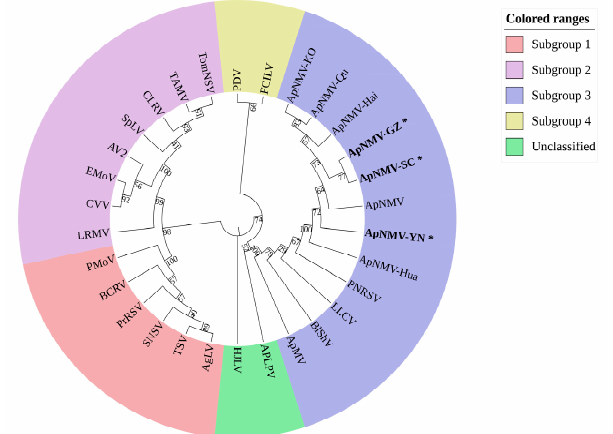
Figure 3. Phylogenetic tree based on the coat protein (CP) amino acid residues of ApNMV isolates with members of the genus ilarvirus. Subgroup 1: Ageratum latent virus (AgLV, NC022129), tobacco streak virus (TSV, NC003845), strawberry necrotic shock virus (SNSV, NC008706), blackberry chlorotic ringspot virus (BCRV, NC011555), privet ringspot virus (PrRSV, NC027930), parietaria mottle virus (PMoV, NC005854). Subgroup 2: asparagus virus 2 (AV2, NC011807), citrus leaf rugose virus (CLRV, NC003546), citrus variegation virus (CVV, NC009536), elm mottle virus (EMoV, NC003570), spinach latent virus (SpLV, NC003810), tomato necrotic streak virus (TomNSV, KT779206), tulare apple mosaic virus (TAMV, NC003835). Subgroup 3: apple mosaic virus (ApMV, NC003480), blueberry shock virus (BlShV, NC022252), lilac leaf chlorosis virus (LLCV, NC025481), prunus necrotic ringspot virus (PNRSV, NC004364). Subgroup 4: fragaria chiloensis latent virus (FClLV, NC006568), prune dwarf virus (PDV, NC008038). No subgroup determined: American plum line pattern virus (APLPV, NC003453), humulus japonicus latent virus (HJLV, NC006066). ApNMV isolate from Japan (P129, LC108995), ApNMV isolate from Korea (KO-276940, LC108995), ApNMV isolate from Shandong Province, China (ApNMV-Hai, ApNMV-Hua, and ApNMV-Qu, MG924900, MG924901, and MG924902), ApNMV isolate from Yunnan Province, China (ApNMV-YN), ApNMV isolate from Guizhou Province, China (ApNMV-GZ), and ApNMV isolate from Sichuan Province, China (ApNMV-SC) were